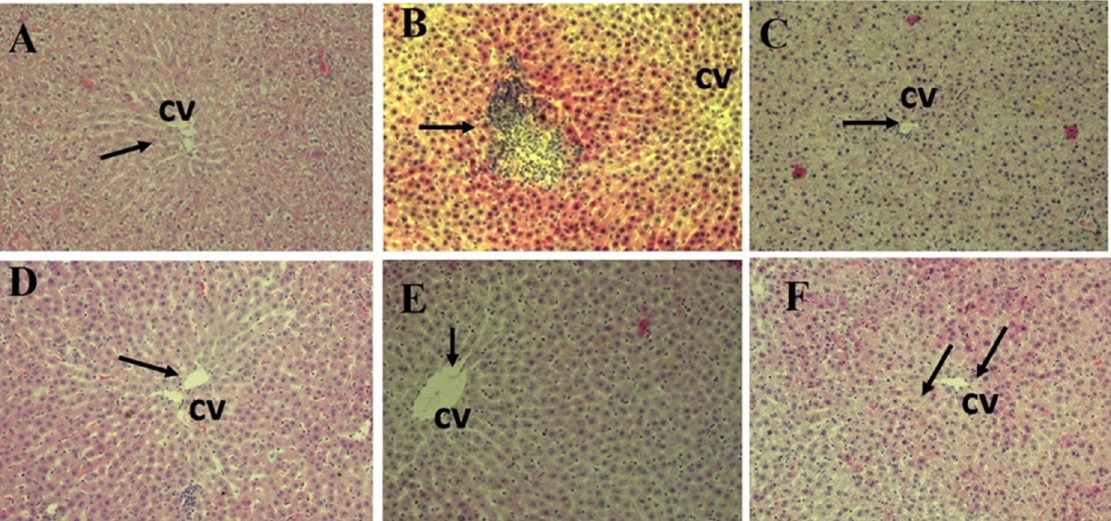
Figure 11. Histopathological examination of liver sections stained with H&E (200X). ( A ) Control; ( B ) BPA; ( C ) MOLE; ( D ) MOLE-BPA; ( E ) Encap. MOLE; ( F ) Encap. MOLE-BPA.